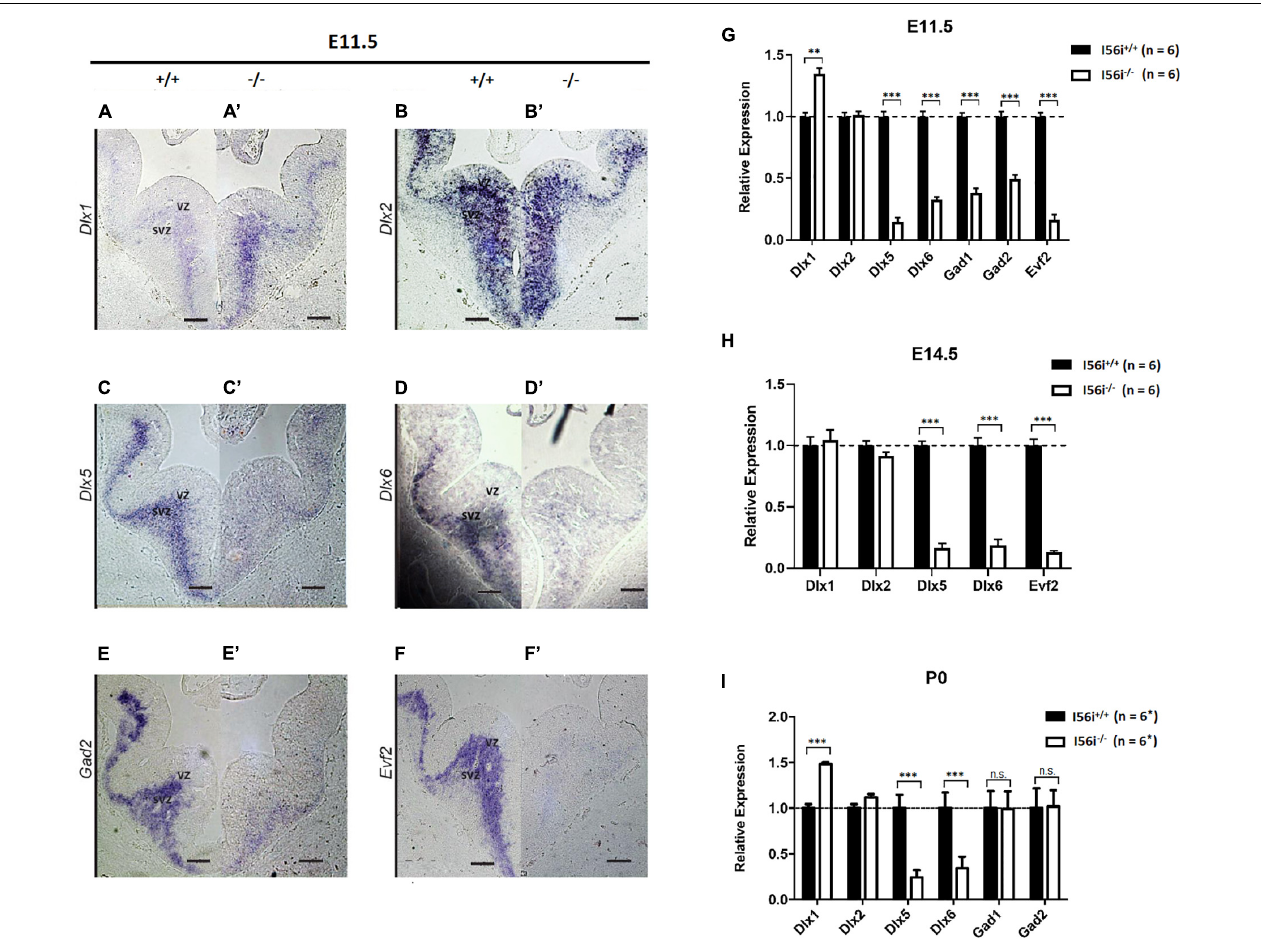
FIGURE 2 | Dlx and Dlx target gene expression are reduced in the developing forebrain of (cid:49) I56i mice. (A–F,A (cid:48) –F (cid:48) ) In situ hybridization on the ventral telencephalon at E11.5 for (A,A (cid:48) ) Dlx1 , (B,B (cid:48) ) Dlx2 , (C,C (cid:48) ) Dlx5 , (D,D (cid:48) ) Dlx6 , (E,E (cid:48) ) Gad2 , and (F,F (cid:48) ) Evf2 . (A–F) WT mice and (A (cid:48) –F (cid:48) ) homozygous (cid:49) I56i mice. Scale bar = 50 µ m. (G–I) qRT-PCR of ventral telencephalon isolated from WT and homozygous I56i ( − / − ) mice. (G) E11.5, (H) E14.5, and (I) P0. Bars are WT (black), homozygous I56i ( − / − ) (white). Data presented as mean for the n values as indicated except for Gad1 and Gad2 at P0 for which n = 3. Error bars represent SEM. Data